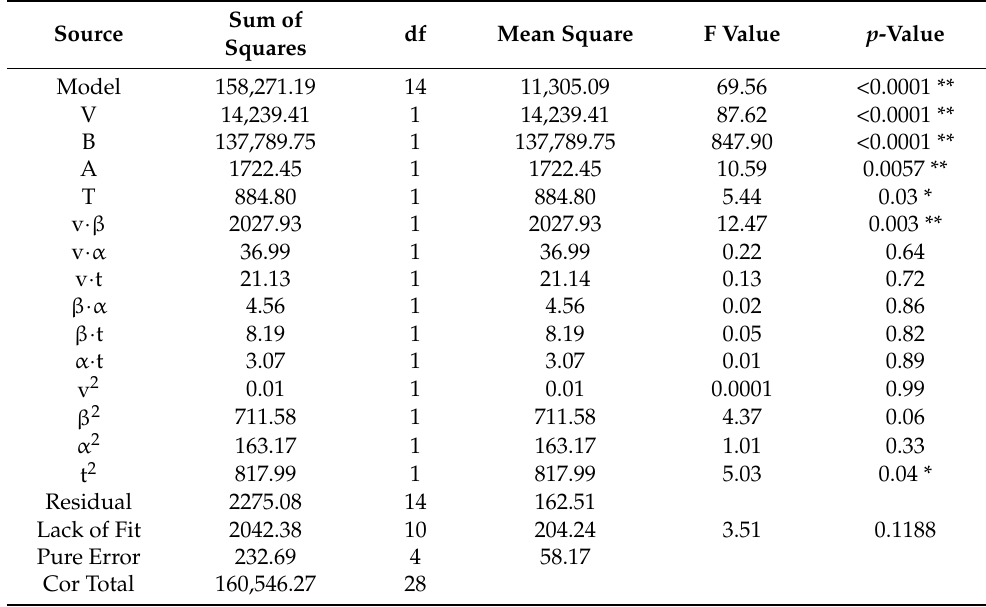
Table 7. Analysis of Variance of Regression Equations.